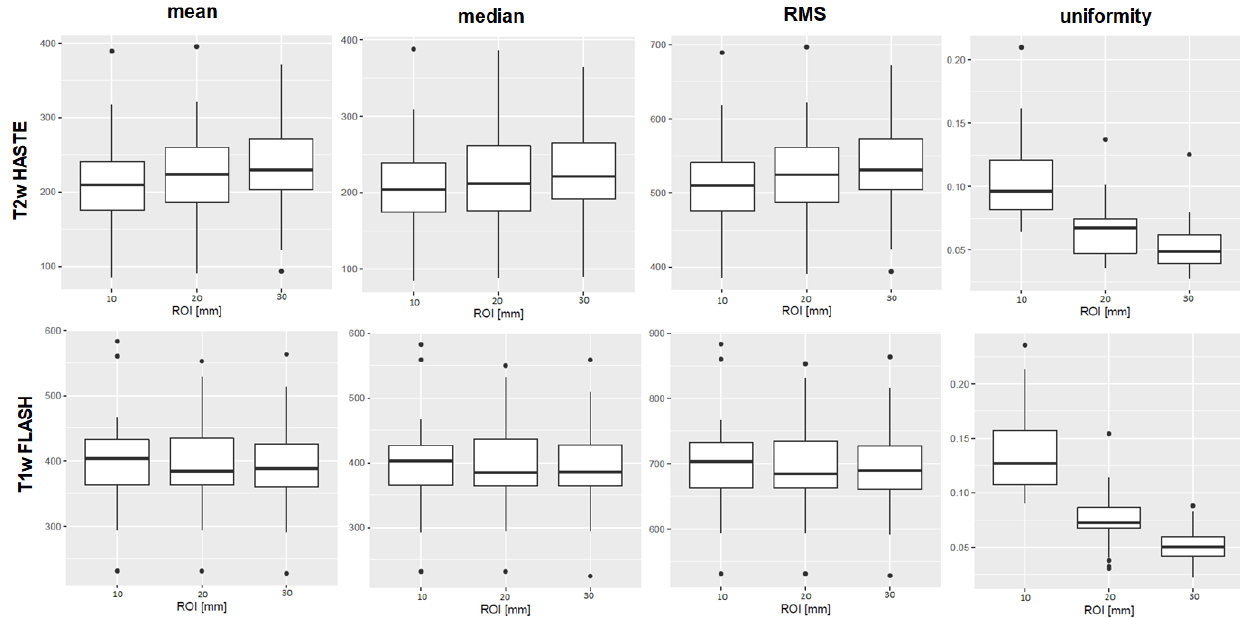
Figure 2. Boxplots of the first-order features mean, median, root mean squared (RMS), and uniformity are shown as examples of the results. The ROI diameters 10, 20, and 30 mm are compiled on the x-axis, the numerical value of the feature on the y-axis. The upper row shows results derived from T2w TSE HASTE images, the lower row from T1w GRE FLASH images, both from 3 Tesla I. For mean, median, and RMS, there was no significant difference between the ROI sizes in the MWU-test. The first-order feature uniformity, as an example, differed significantly in both T1w and T2w sequences. Boxplots of all features, sequences and scanners are provided in the Supplementary File SF4.